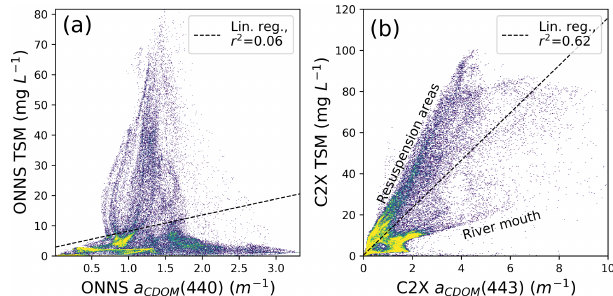
Figure 10. Relationship between (a) ONNS-retrieved a CDOM (440) and TSM concentration and (b) C2X-retrieved a CDOM (440) and TSM concentration for the MERIS scene from 7 September 2010. The relationship, using other scenes from September, does not vary significantly (18 September 2010: ONNS r 2 = 0 . 22 and C2X r 2 = 0 . 55, 19 September 2010: ONNS r 2 = 0 . 23 and C2X r 2 = 0 . 67, 20 September 2010: ONNS r 2 = 0 . 03 and C2X r 2 = 0 .